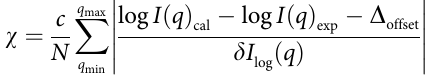
, fractions of secondary structures and sampling efficiency S2 Fig. Comparison of RMSD T